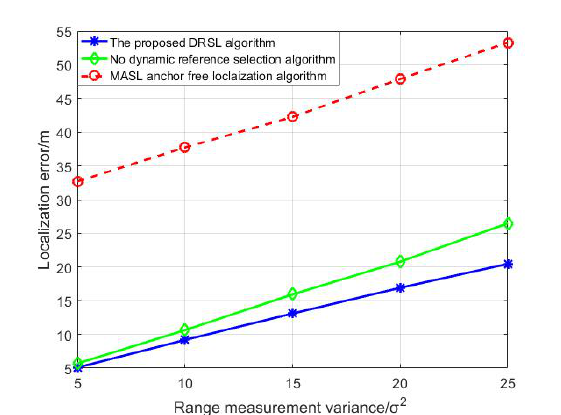
Figure 13. The localization error analysis of different algorithms.